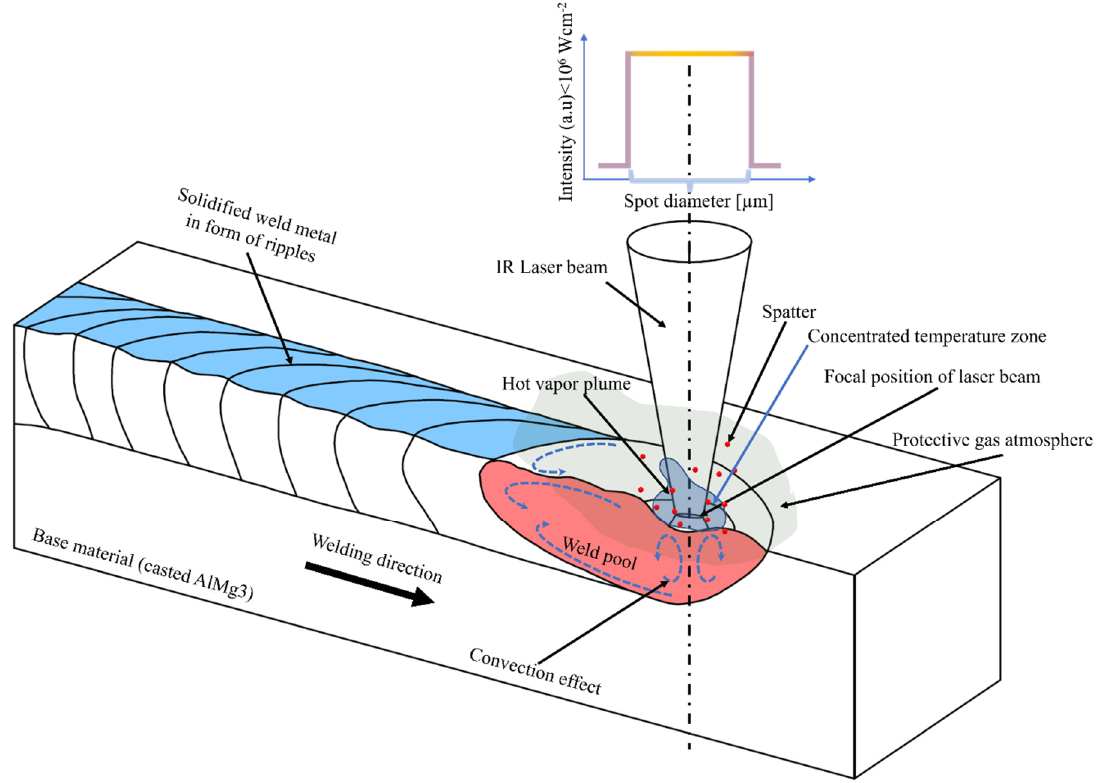
Figure 10. Schematic representation of laser welding process in conduction